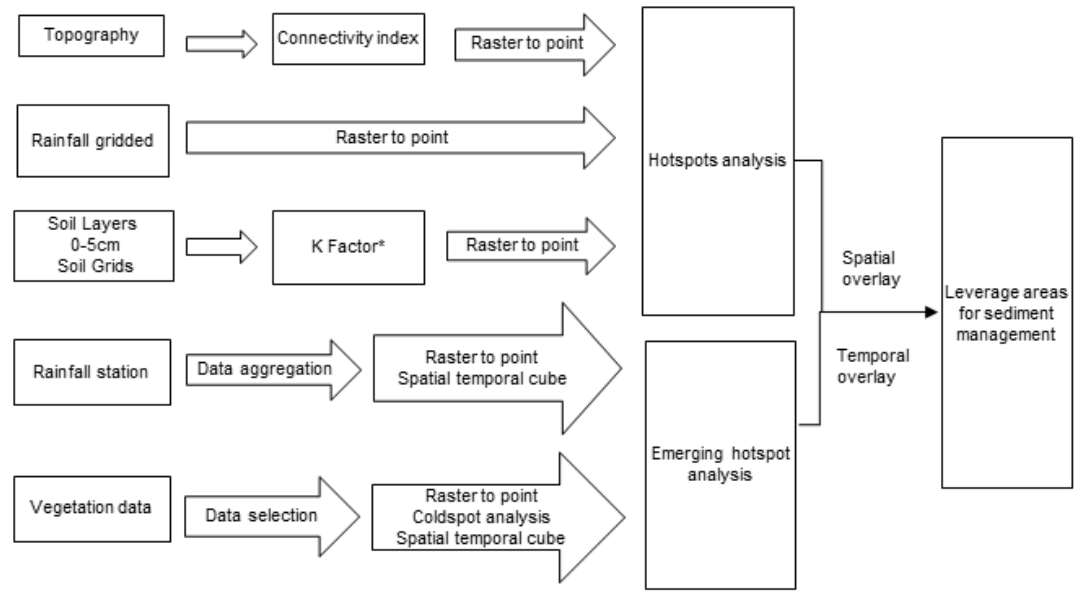
Figure 4. Workflow. Details are presented in the text.